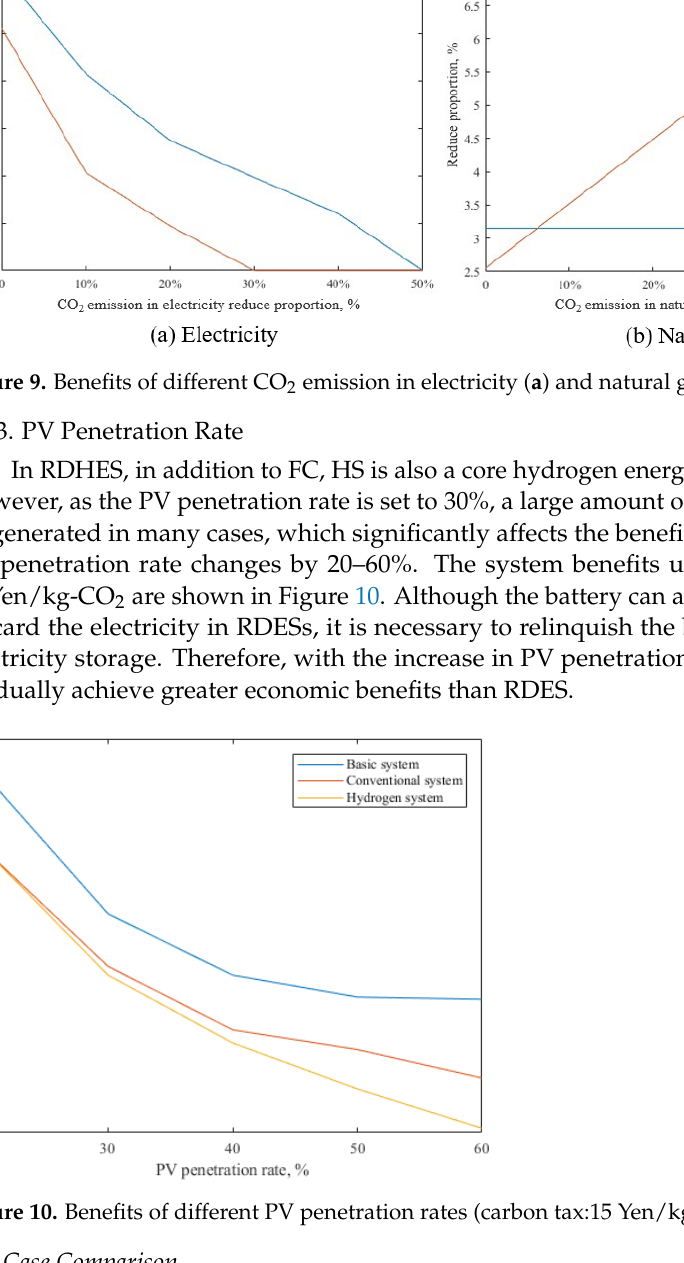
nomic advantage of RDHES on the demand side will be 5–10 years longer than that of